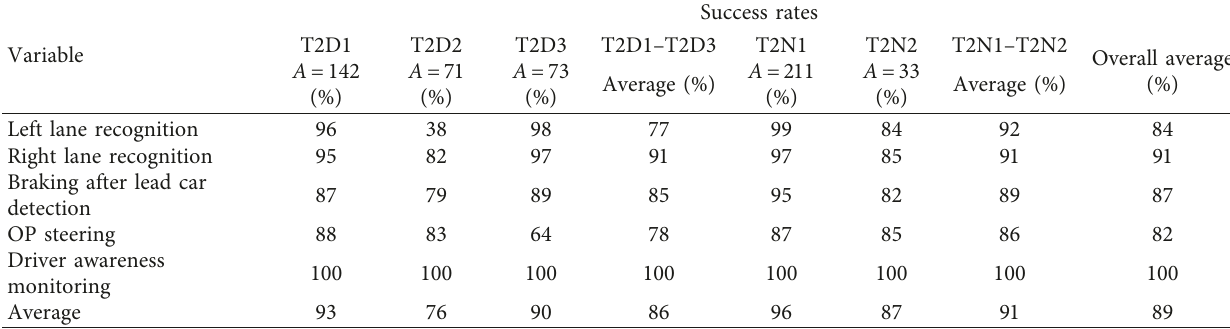
Table 8: Analysis of all drives in